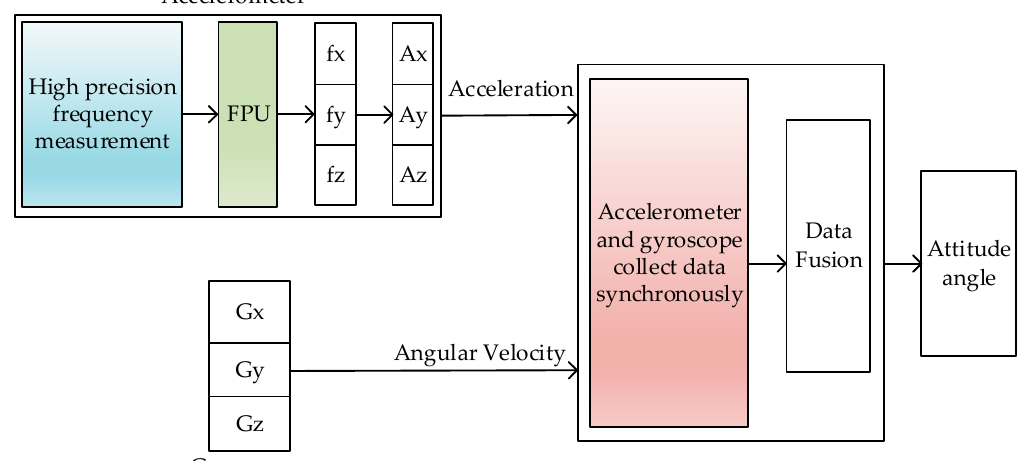
Figure 2. The block diagram of our work.